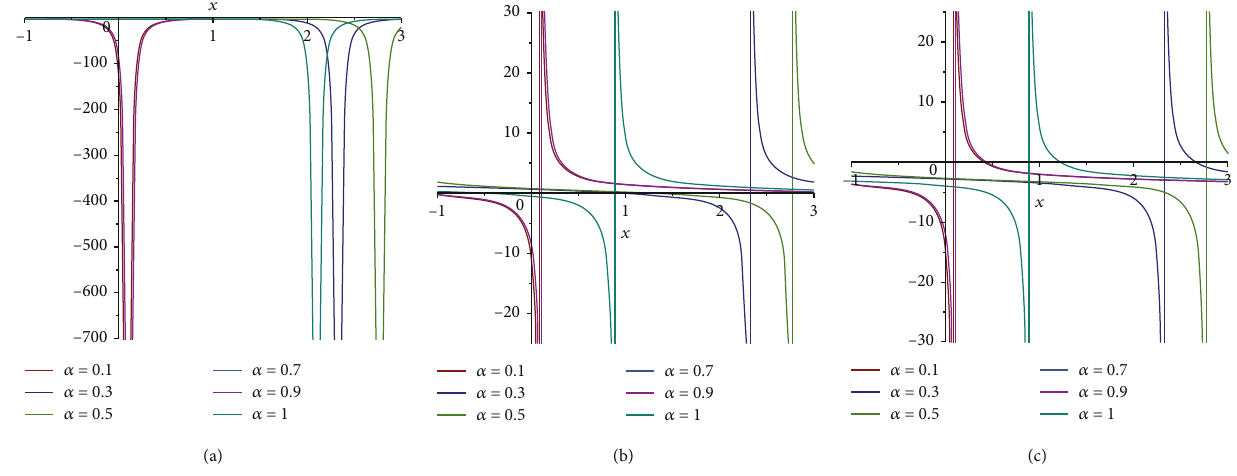
= τ = c = 1, t = 1, ν = − 7 for differentvalue of α − 1